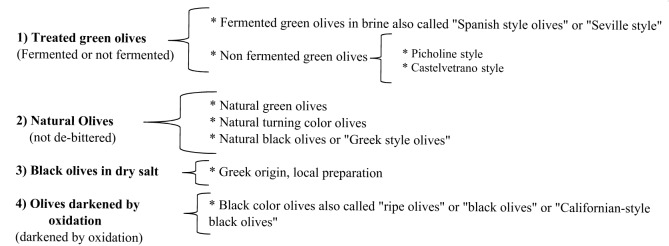
Table olives sorted regarding the economic importance from global standpoint (adapted from Rejano et al., 2010).